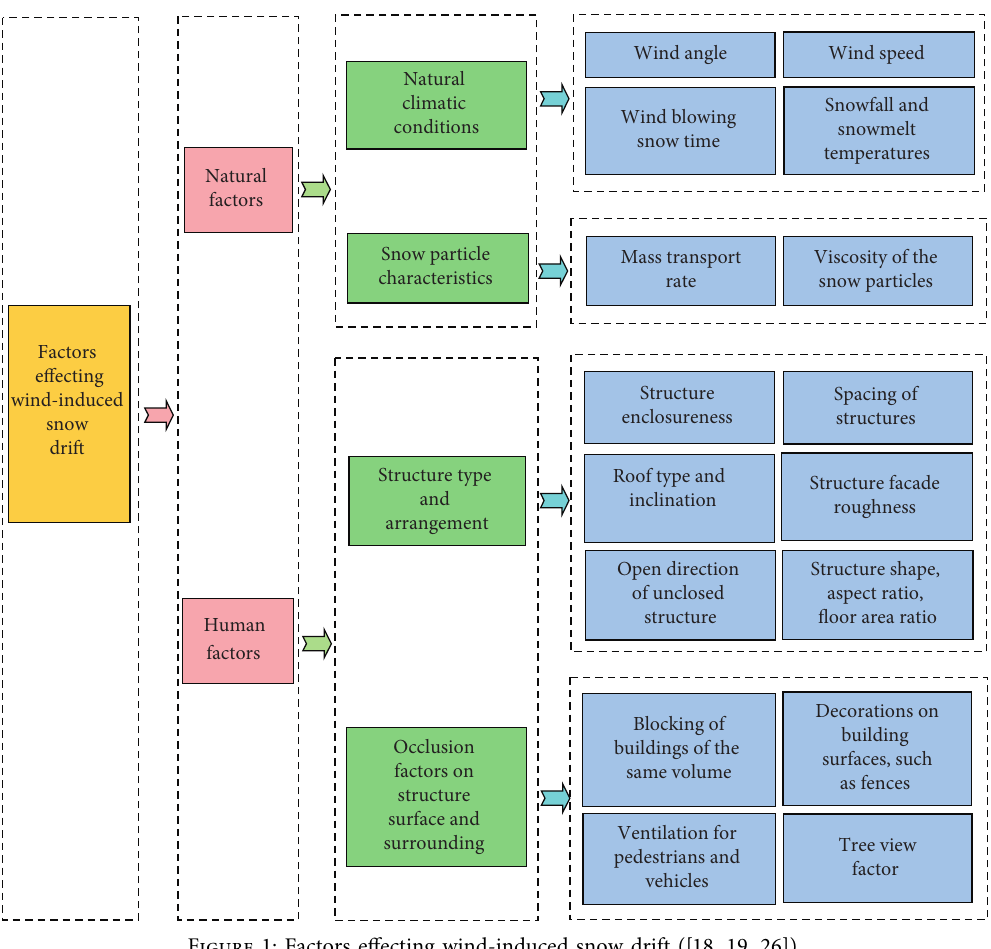
Figure 1: Factors effecting wind-induced snow drift ([18, 19, 26]).